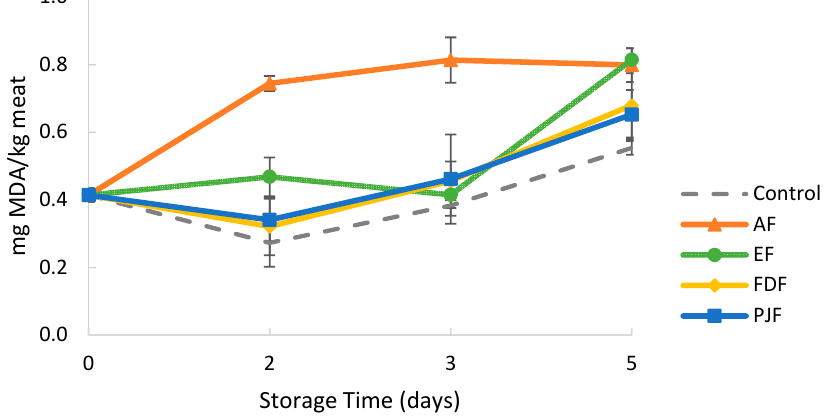
Figure 5. 2-thiobarbituric acid (TBARS) values of meat samples during five days of storage of meat at 4 °C. The results were expressed as mean malonaldehyde (MDA) concentration in milligram per kilogram of meat. Alginate film with microparticles with encapsulated hydroalcoholic extract (EF), alginate film with pineapple-peel-juice microparticles (PJF), alginate film with freeze-dried peel powder (FDF), and control films only with alginate (AF).